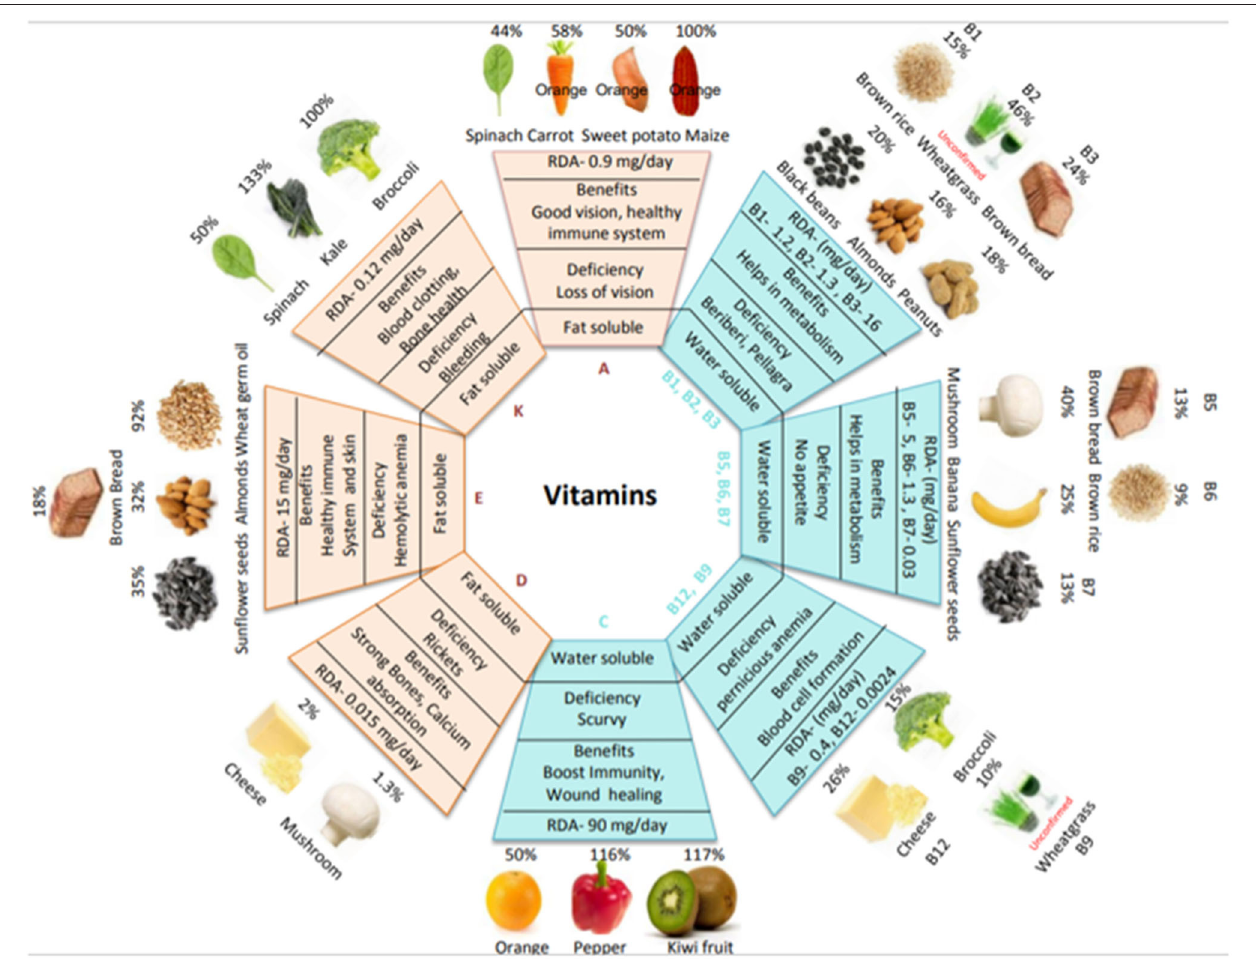
FIGURE 1 | Vitamin types, food sources, benefits, and deficiencies. The diagram shows the RDA requirement of each vitamin, a variety of plant-based food sources to ensure an adequate supply of vitamins, primary functions, and deficiency disease symptoms. The %RDA for various food sources is based on adult males and is